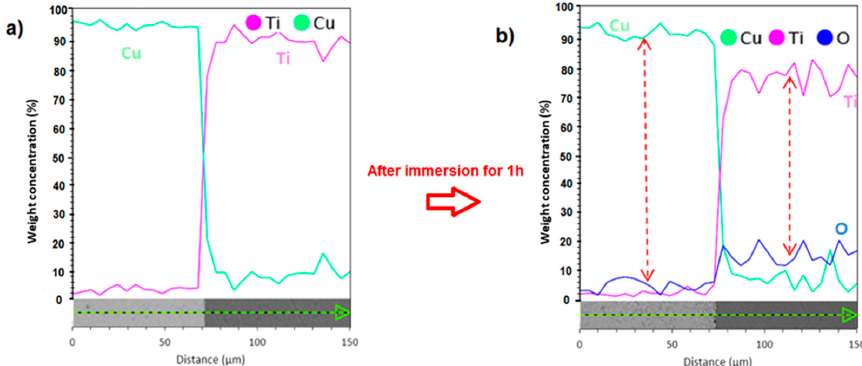
Figure 14. Ti, Cu and O element distribution measured by EDS line analysis ( a ) before and ( b ) after immersion in 3.5 wt.% NaCl corrosive solution for 1 h. The amount of elemental O before exposure was below the detection limit of our EDS analyzer.